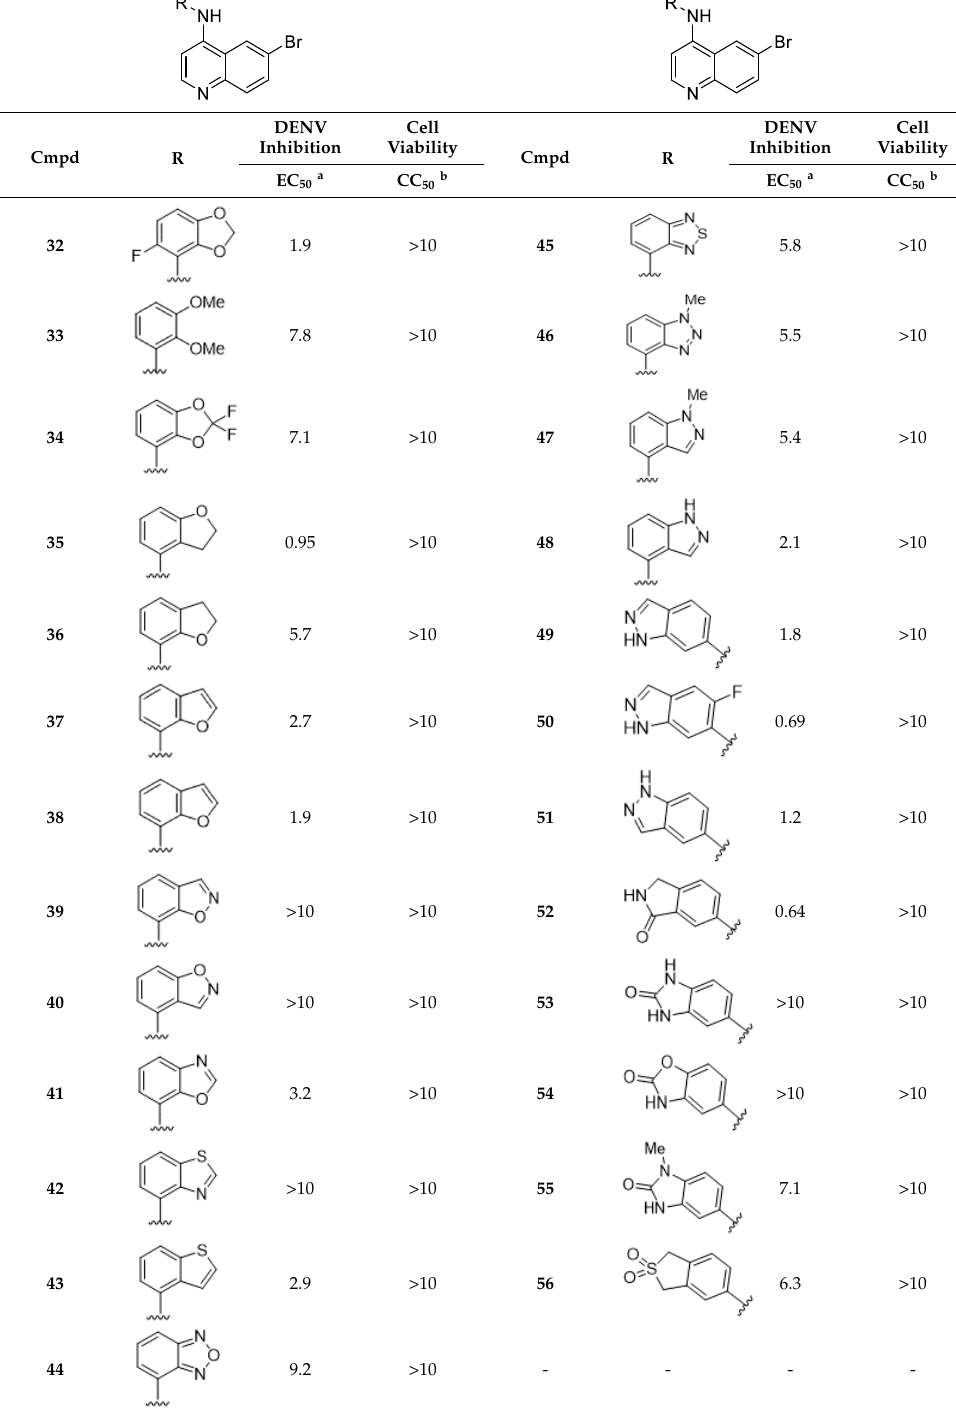
Table 4. Screening results of anti-DENV activity following up on 28 – 31 .